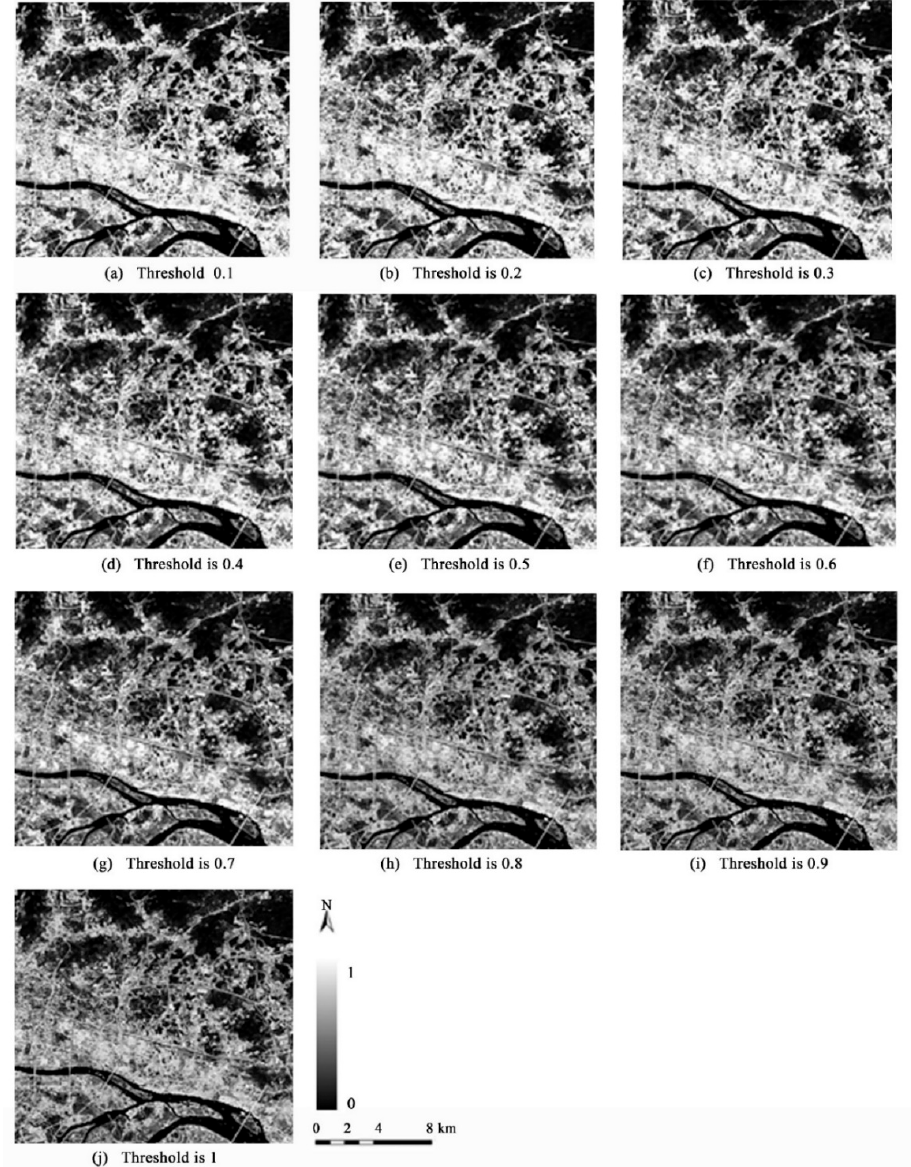
Figure 8. Information on impervious surfaces at different thresholds obtained through the threshold hierarchical method (THM).